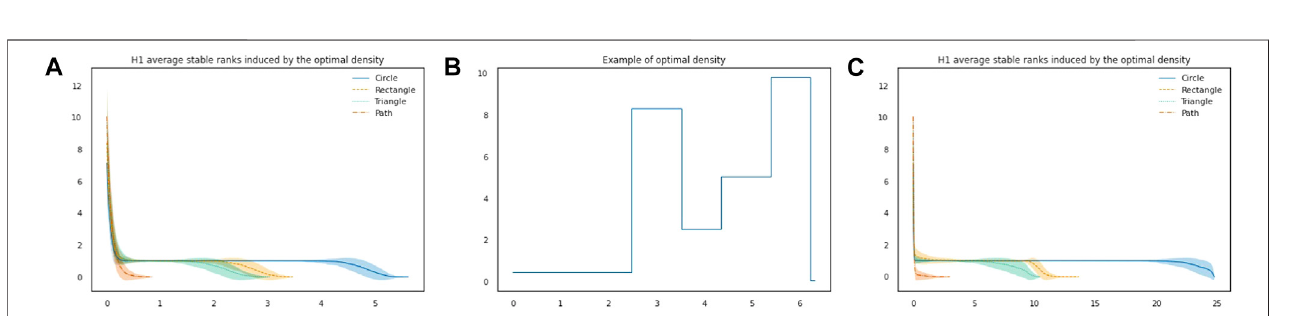
Frontiers in Applied Mathematics and Statistics |